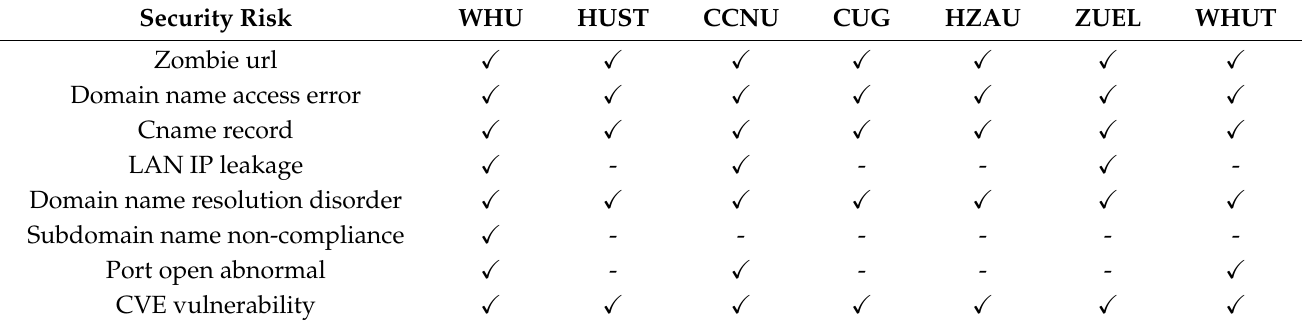
Table 18. The network security risks of seven universities found by